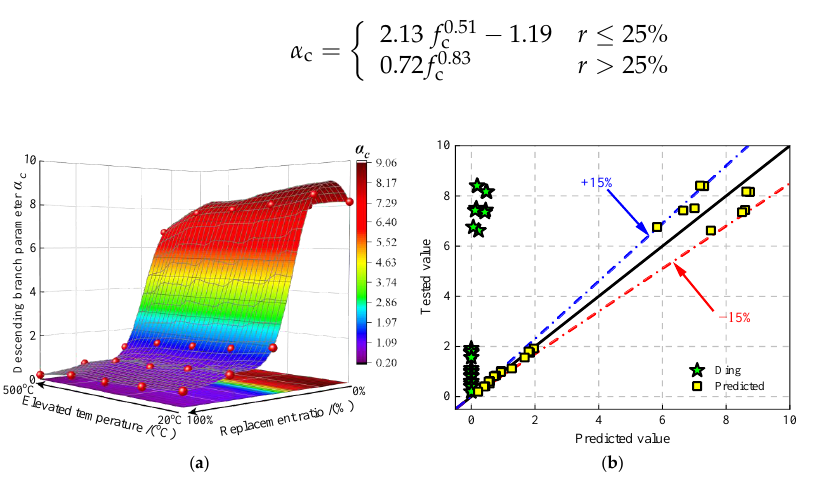
Figure 15. The values of descending branch parameter α c for JNC. ( a ) Surface of α c under the effect of replacement ratios and elevated temperatures. ( b ) Comparison of the tested values and the predicted values [37].